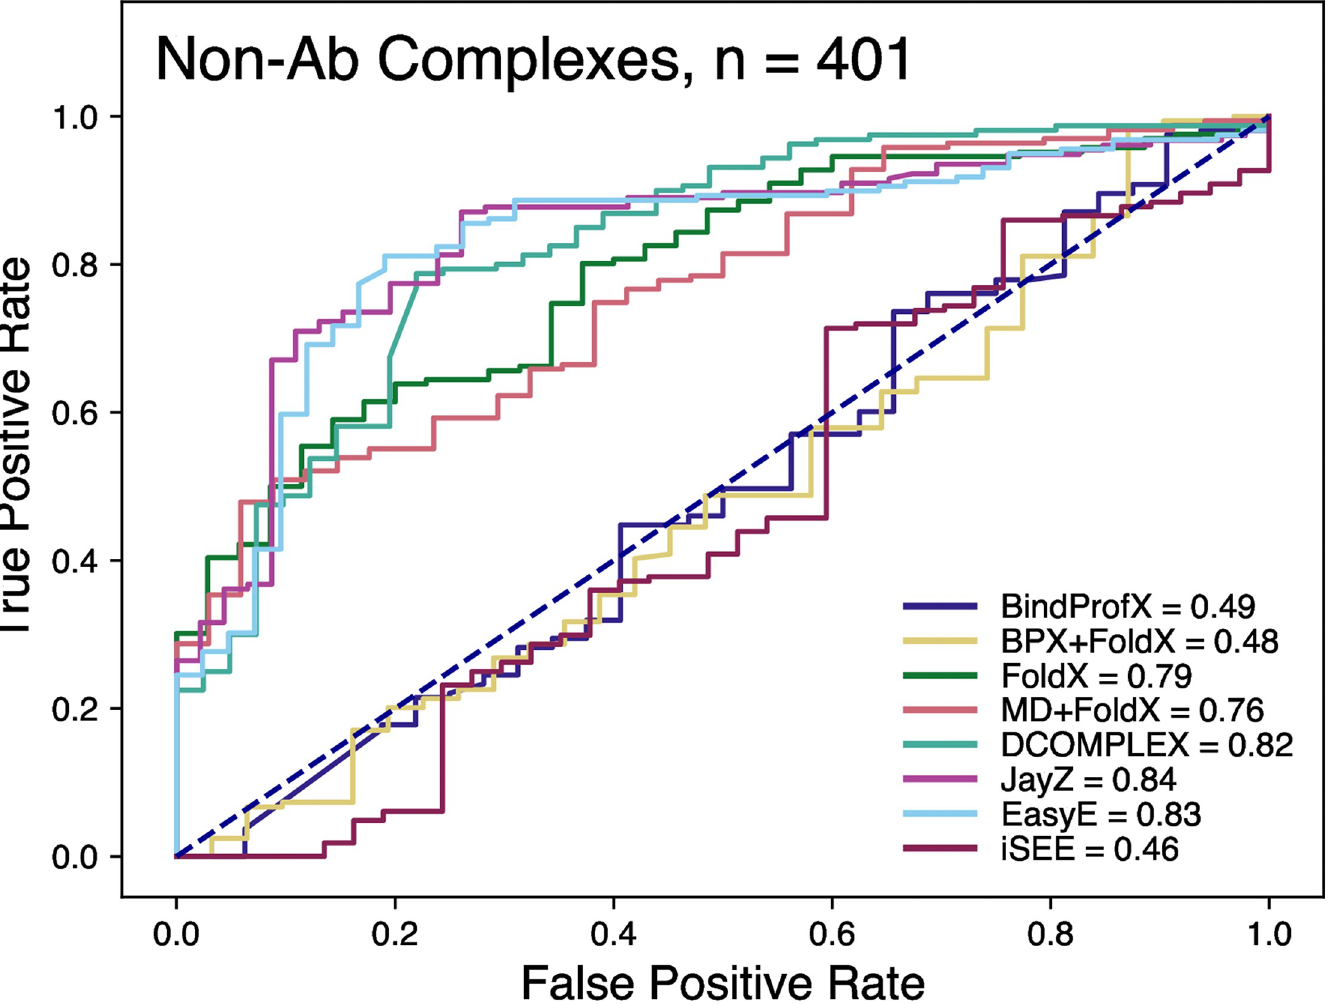
Fig 3. Receiver operating characteristic (ROC) curves for non-Ab complexes of the classification of variants as stabilizing ( ΔΔ G < -0.5 kcal/mol) or destabilizing ( ΔΔ G > 0.5 kcal/mol). The values in the legend represent the area-under-curve (AUC). The higher the value, the better method is at discriminating between destabilizing and destabilizing